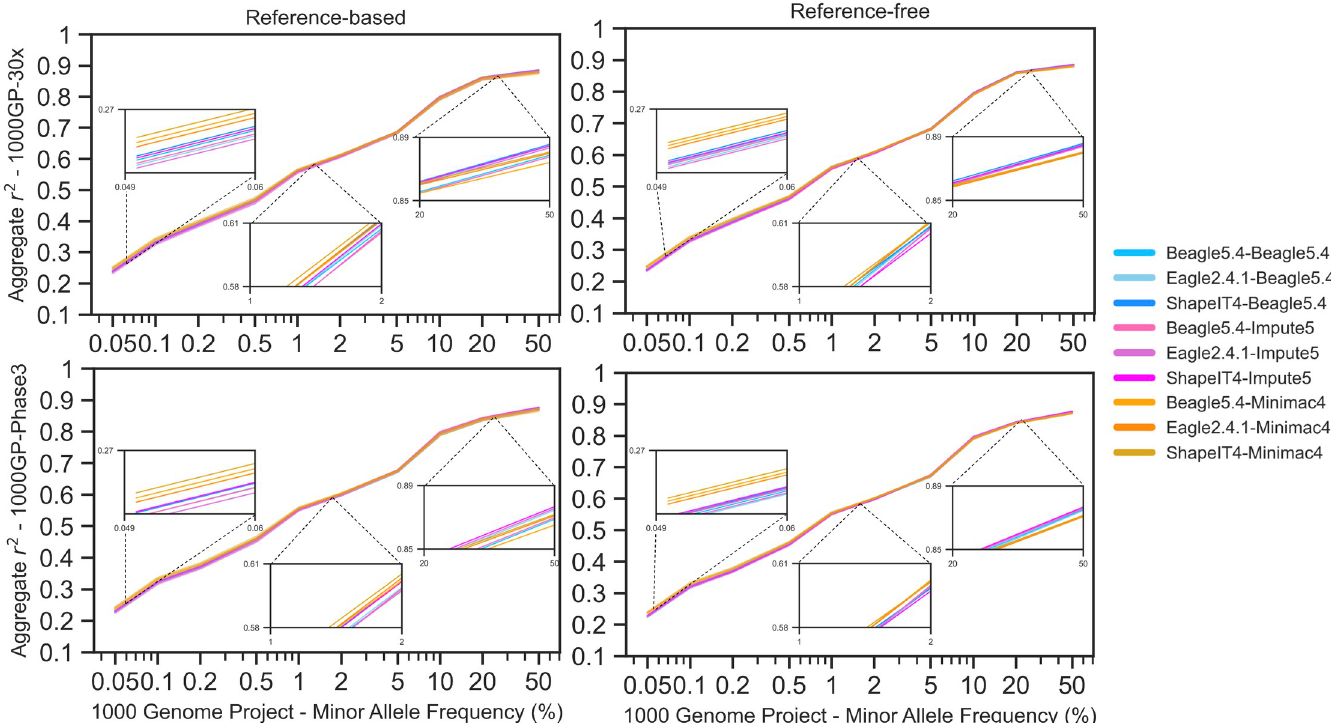
Fig 9. Imputation performance for chromosome 20 using EBB data with 2280 individuals with 2 reference panels and 2 phasing approaches. Blue colors indicate Beagle5.4, violets indicate Impute5 and oranges indicate Minimac4.